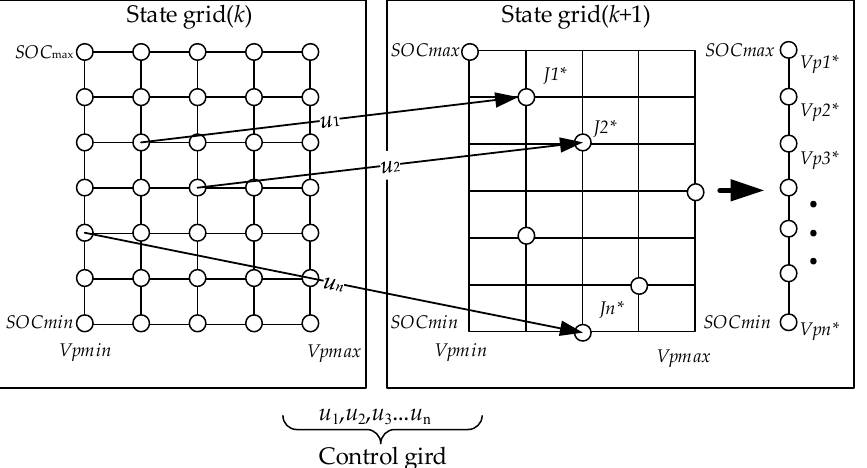
Figure 6. Schematic diagram of dimensionality reduction of the corresponding relationship between state and optimal cost.